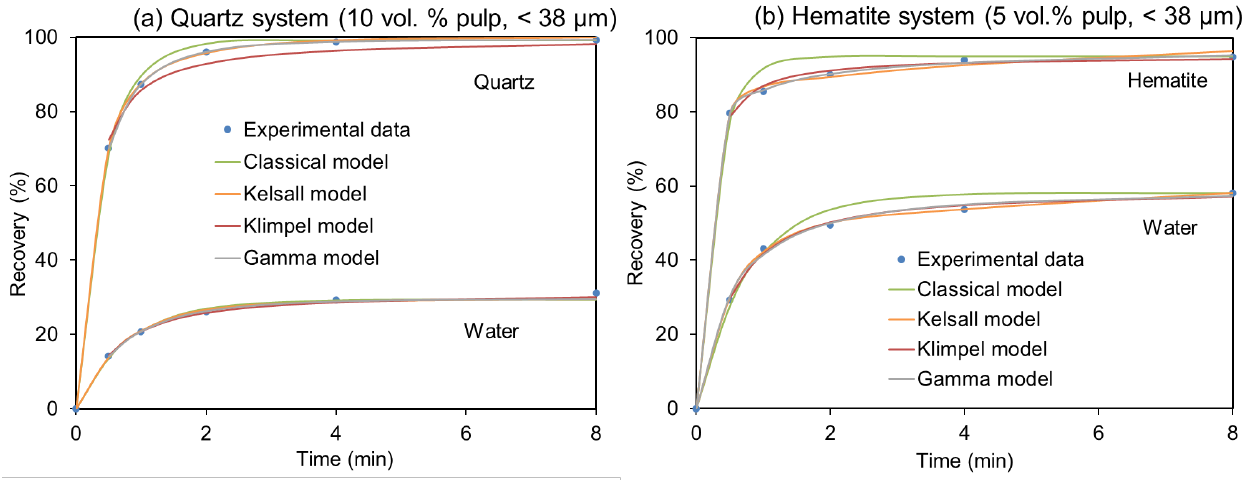
Figure 5. Selected examples of different models fitted to experimental data. ( a ) Quartz flotation recovery at 10 vol.% and −38 µm, and ( b ) hematite flotation recovery at 5 vol.% and −38 µm.